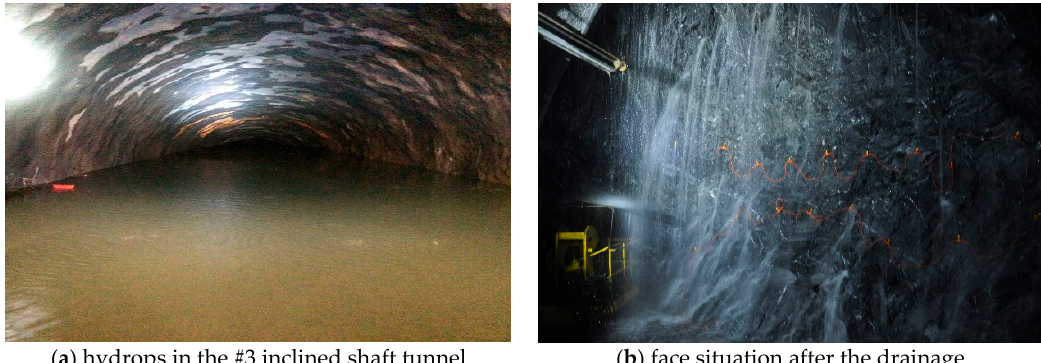
Figure 7. XJ3K0 + 396 water inrush situation in #3 inclined shaft of the Yuelongmen Tunnel.